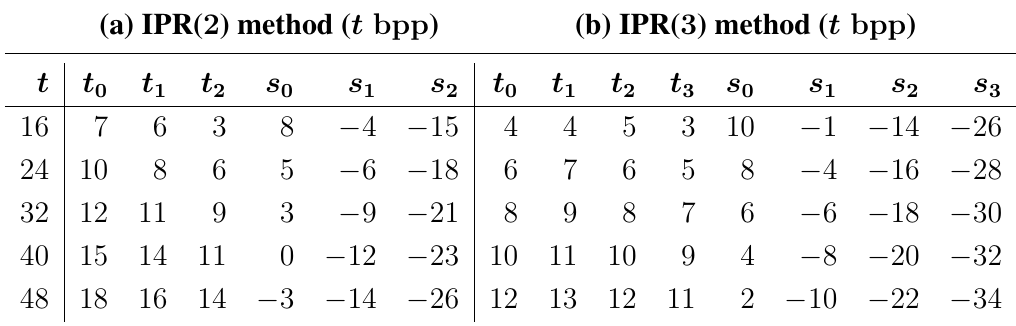
Table 2. Details of fixed-point implementations. Total wordlengths t , in bpp , are selected to be integer multiples of whole bytes. Here, t represents the wordlengths, also in bpp , of k parameters ˆ B , shown in Figure 2, and s represents their binary-point positions. For each jk k pixel j , floating-point parameters ˆ b are quantized to get integer parameters ˆ B jk